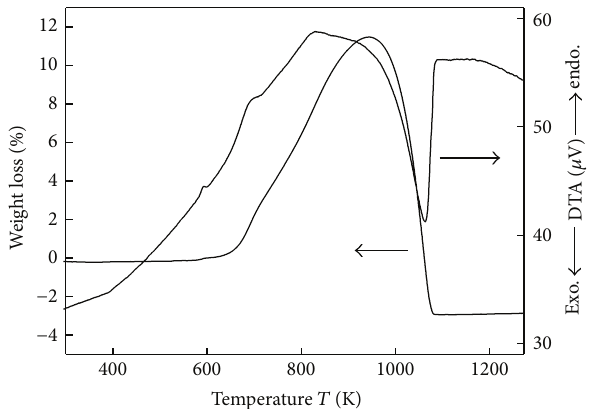
Figure 7: TG-DTA curves of dolomite pyrolysis products in CO 2 atmosphere up to 1273